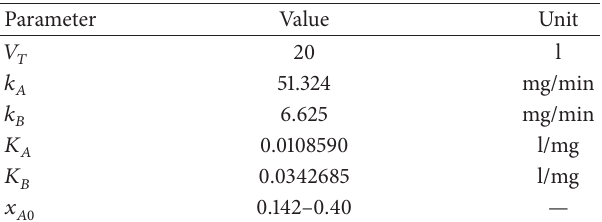
Table 2: Kinetic model parameters for the mixture.